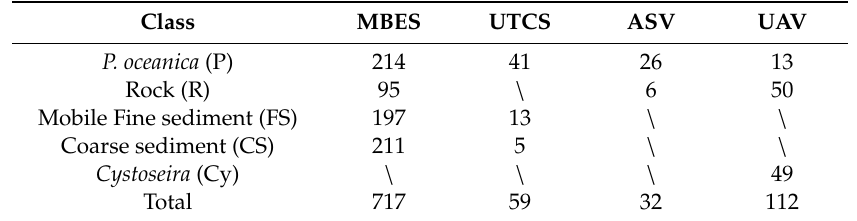
Table 1. Number of ground-truth data derived by the acoustic data MBES, and collected through the Underwater Towed Camera Systems (UTCs), ASVs DEVSS and